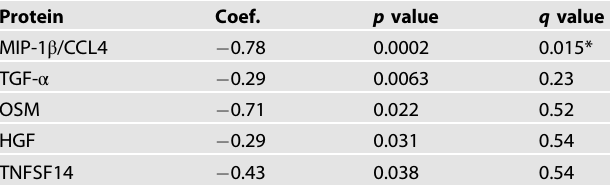
Table 3. Associations between methylation level of TLR4 cg05429895 and plasma protein levels.